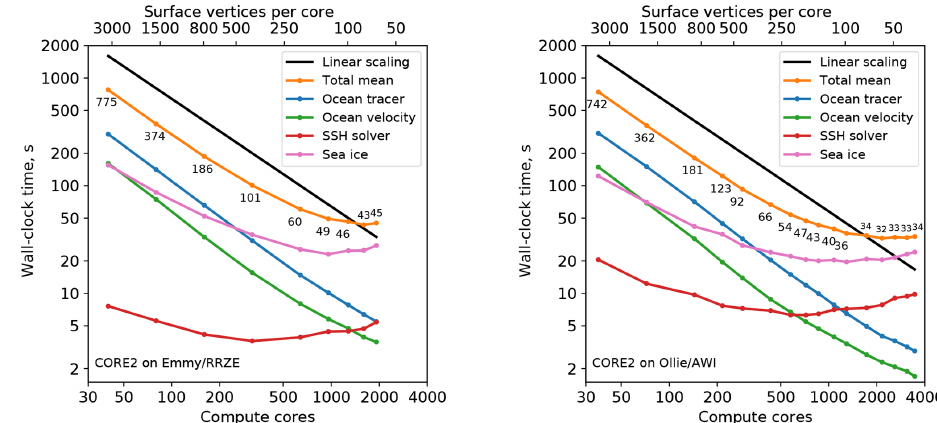
Figure 4. Scaling results for the CORE2 mesh on Emmy (RRZE Erlangen) and Ollie (AWI Bremerhaven) compute clusters. The black line indicates linear scaling and the orange line (and the number labels) gives the mean total computing time over the parallel partitions.